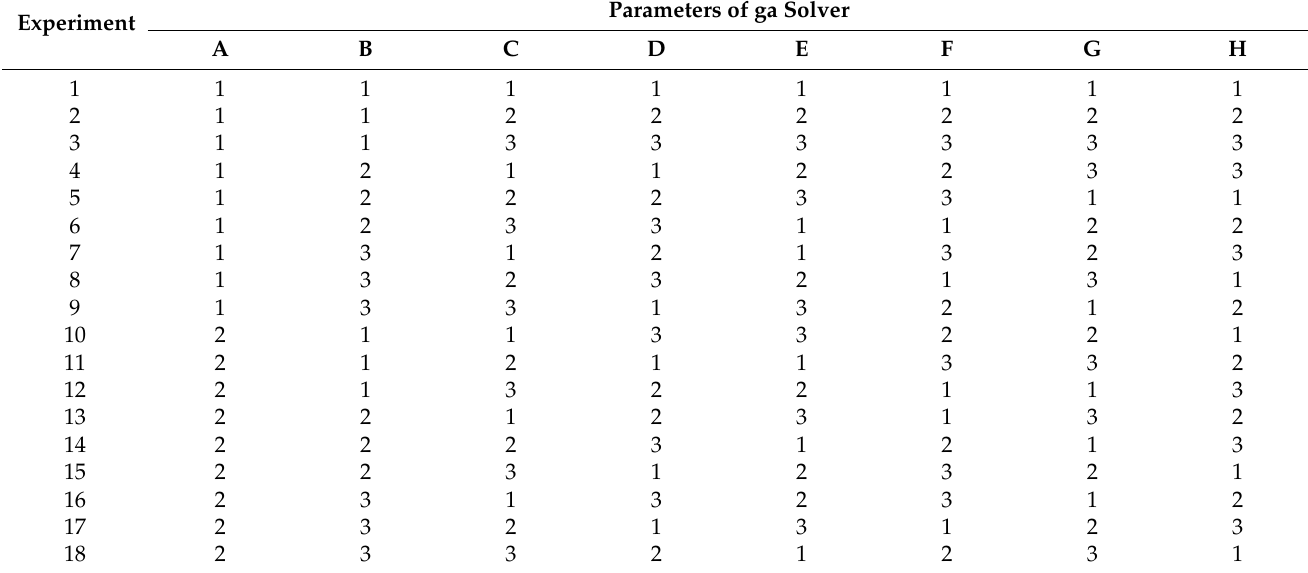
Table 2. Taguchi Orthogonal Array design L18 (2 1 3 7